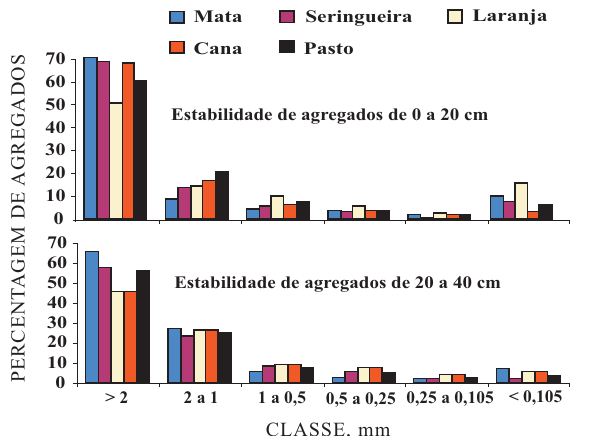
Figura 2. Distribuição e estabilidade de agregados em água para os solos sob mata, seringueira, laranja, cana e pastagem, nas profundidades de 0 a 20 e 20 a 40